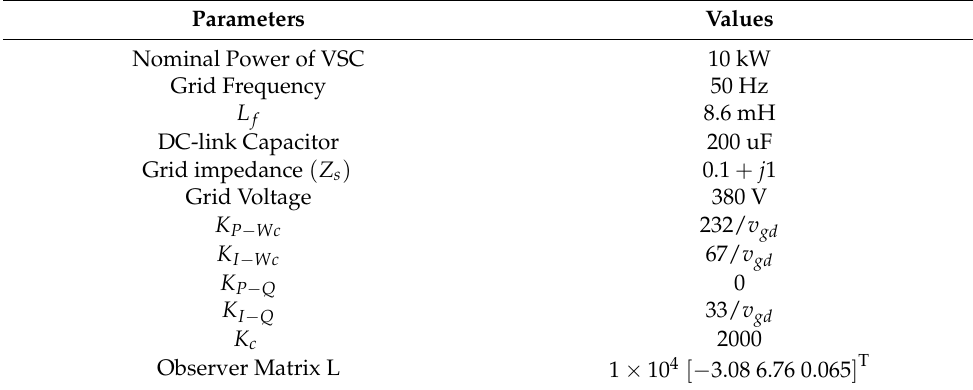
Table 1. Parameter Values of the studied system.